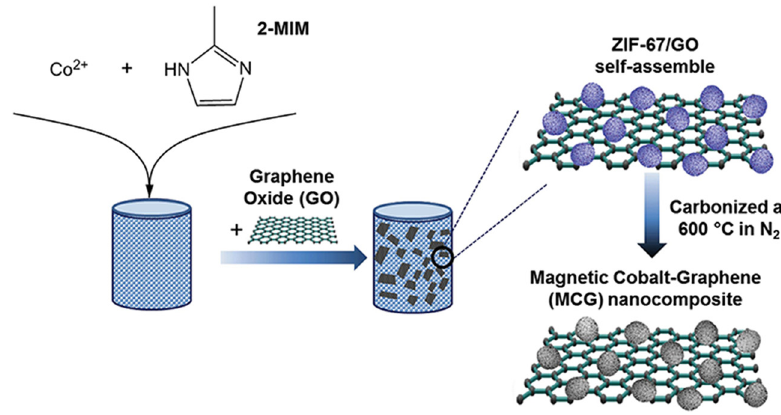
Figure 8: Schematic diagram of synthesis of magnetic cobalt – graphene ( MCG ) nanocomposite [ 208 ]